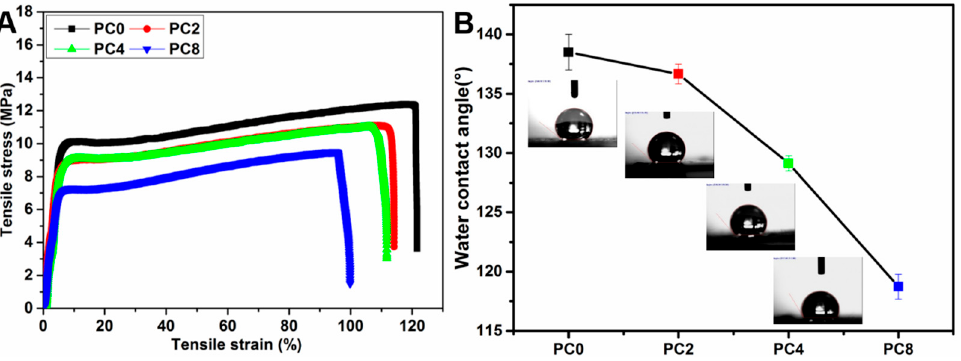
Figure 4. ( A ) The stress-strain curves and ( B ) water contact angles of PC0, PC2, PC4 and PC8 nanofibrous scaffolds.